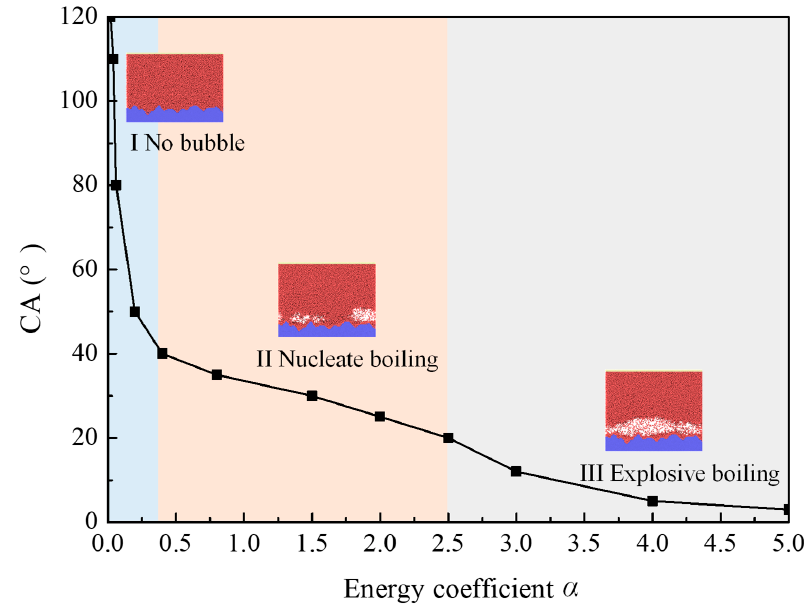
Figure 6. Phage–change diagram for the different energy coefficient. The wall superheating equals 80